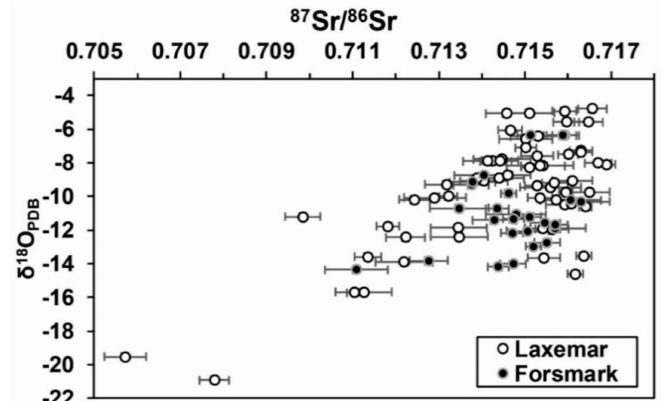
Figure 8. 87 Sr / 86 Sr vs. δ 18 O from spatially related spot analysis for calcite from Laxemar-Äspö and Forsmark. δ 18 O values are from Drake et al. 2017 [34]. As shown in Figures 5 and 6, the low 87 Sr / 86 Sr values are from the interiors of the calcite crystals and increase towards the rims and therefore mark a temporal evolution, that in the present figure goes from lower left to upper